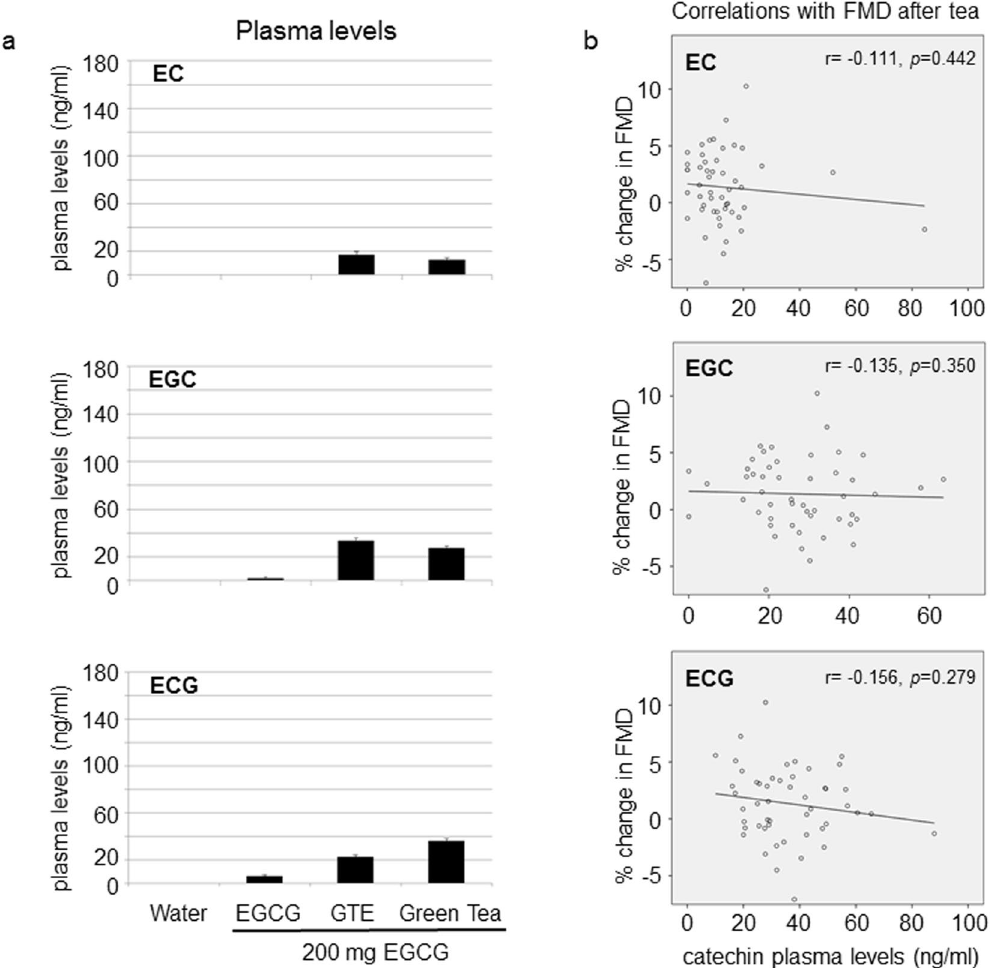
Figure 4. No correlations of catechin plasma levels with changes in FMD. Plasma levels of EC (epicatechin), EGC (epigallocatechin), and ECG (epicatechin gallate) after hydrolysis (sum of free and conjugated catechins) two hours after consumption ( a ). The scale of the y axes are equal to Fig. 3 to facilitate comparisons with EGCG levels. Data are means ± SEM from n = 50 subjects for water, EGCG, and green tea and n = 49 for GTE. Correlations of catechin plasma levels with FMD changes after tea consumption ( b ). Non-significant negative correlations were observed between catechin plasma levels and FMD changes (Spearman’s). Data are from n = 50